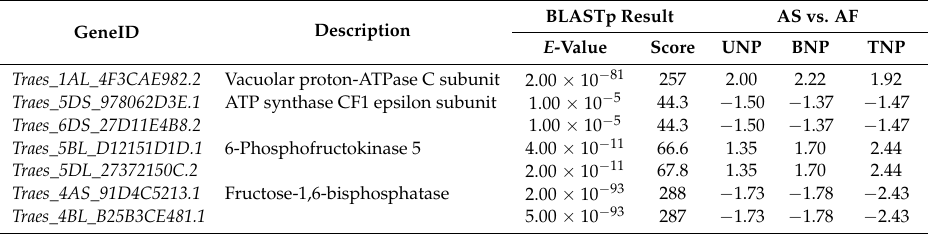
Table 4. Differentially abundant proteins related to energy metabolism in fertile and sterile